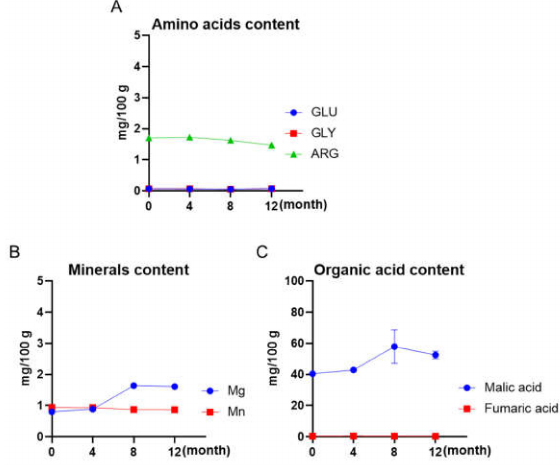
Figure 3. Changes in maple water chemicals including amino acids (GLU, GLY, and ARG) ( A ), minerals (Mg and Mn) ( B ), and organic acids (malic acid and fumaric acid) ( C ) during a storage time of 12 months at room temperature. Each sample was measured at time points of 0, 4, 8, and 12